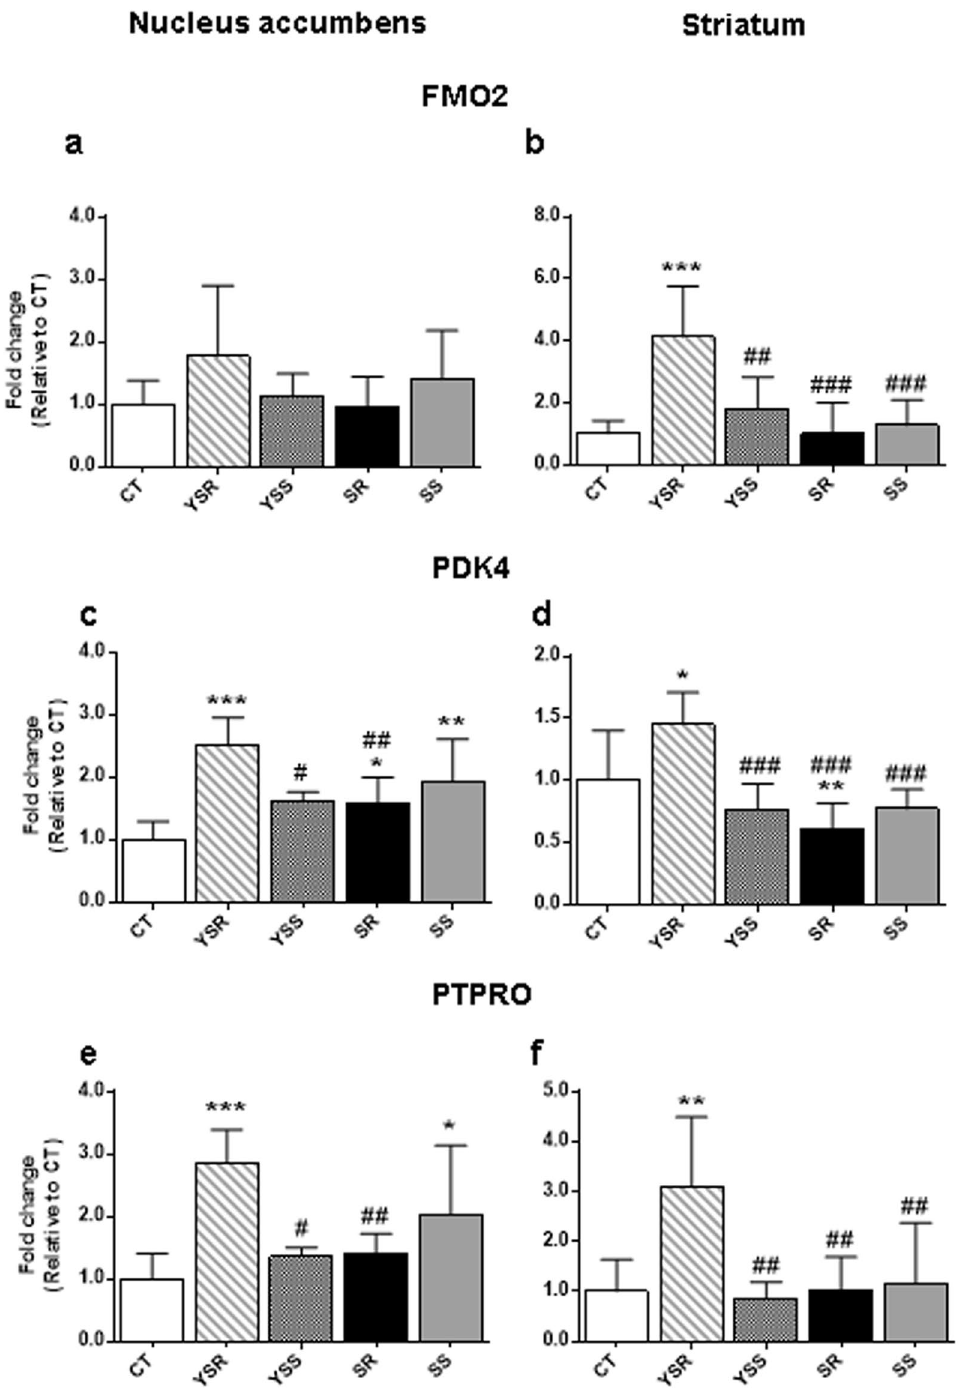
Figure 6. PCR measures of changes in FMO2, PDK4, and PTPRO mRNA levels in the rat NAc and dorsal striatum after a month withdrawal from methamphetamine SA and footshocks. We conducted quantitative PCR using individual RNA from the NAc ( a , c , e ) and dorsal striatum ( b , d , f ) of rats from the 5 groups of rats. The YSR that received many non-contingent footshocks (291 ± 39) showed significant increases in FMO2 in the dorsal striatum ( b ) but not in the NAc ( a ). YSR rats also experienced increases in PDK4 in both the NAc ( c ) and dorsal striatum ( d ). PTPRO mRNA levels were also increased in the NAc ( e ) and dorsal striatum ( f ) of YSR rats. Values are means ± SEM fold changes relative to the control group. Key to statistics: * p < 0.05, ** p < 0.01, *** p < 0.001, in comparison to the control group; #p < 0.01, ##p < 0.01, ###p < 0.001, in comparison to the YSR